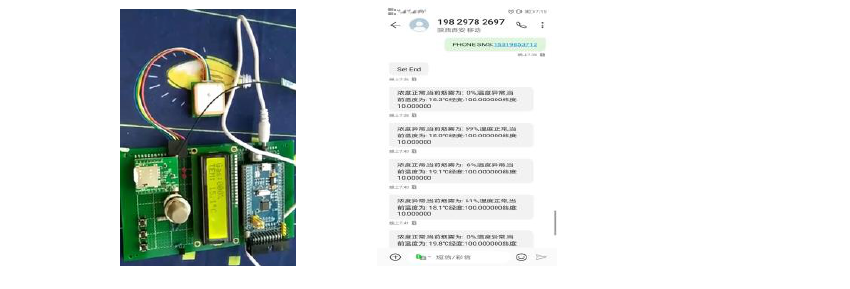
Fig. 12 . Design objective. Fig. 13 . Location information short